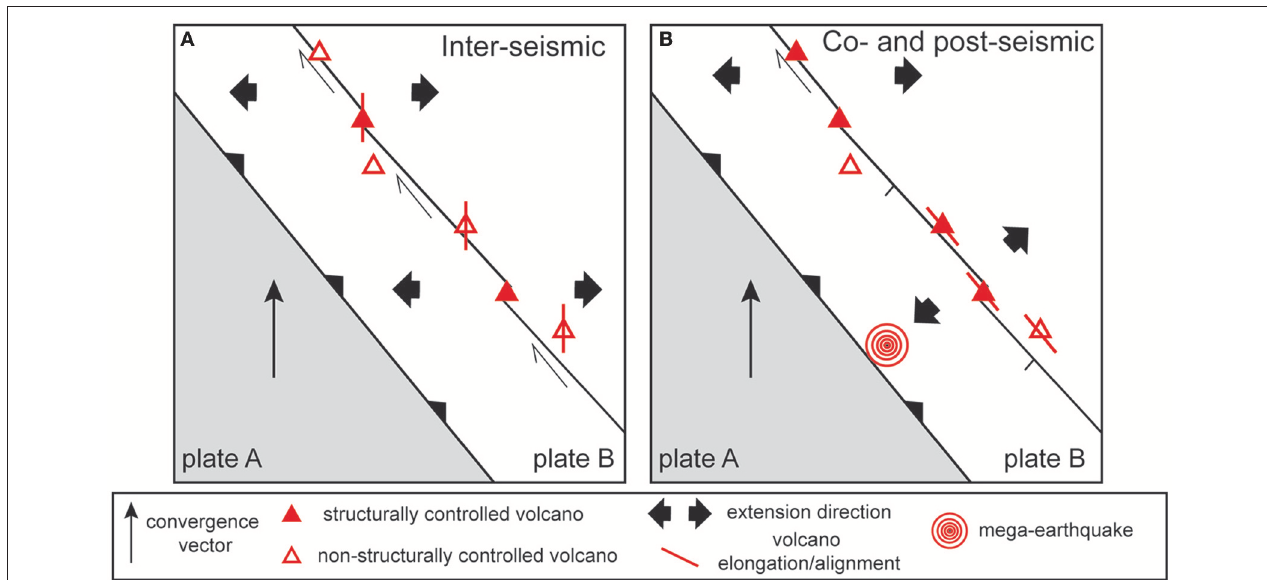
FIGURE 12 | Summary of the possible tectono-magmatic conditions along an obliquely convergent volcanic arc. (A) Normally, as during the inter-seismic period, the arc is characterized by the activity of strike-slip (dextral, in this case) structures associated with strain partitioning; part of these structures control the location of the volcanoes (“structurally controlled volcano”); the location of other volcanoes (“non-structurally controlled volcano”) away from the strike-slip zone may be explained by other processes, as slab depth or convergence-orthogonal extension, controlling also volcano alignment and elongation. (B) During transient periods (co- and post-seismic periods due to the activity of mega-earthquakes) the arc may undergo arc-normal extension, with the local reactivation of the strike-slip faults as normal faults; the alignment and elongation of volcanoes may partly reflect these transient conditions, becoming subparallel to the